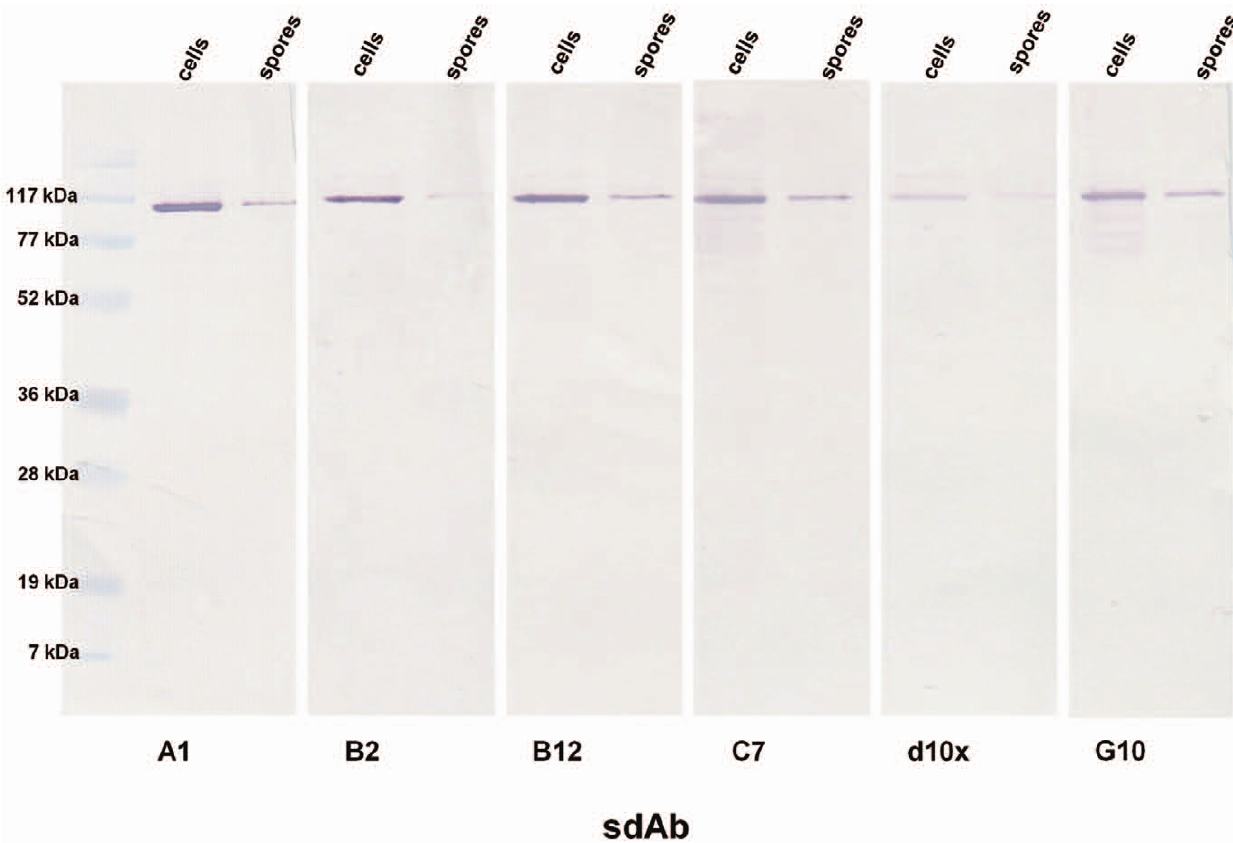
Figure 2. Immunoblot analysis of sdAb target protein. B. anthracis Sterne strain cell and spore lysates were separated via SDS-PAGE for immunoblotting using each of the sdAbs.